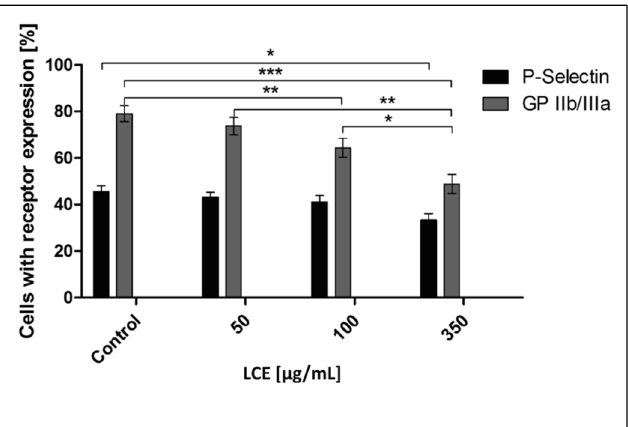
differences: * p < 0.05).